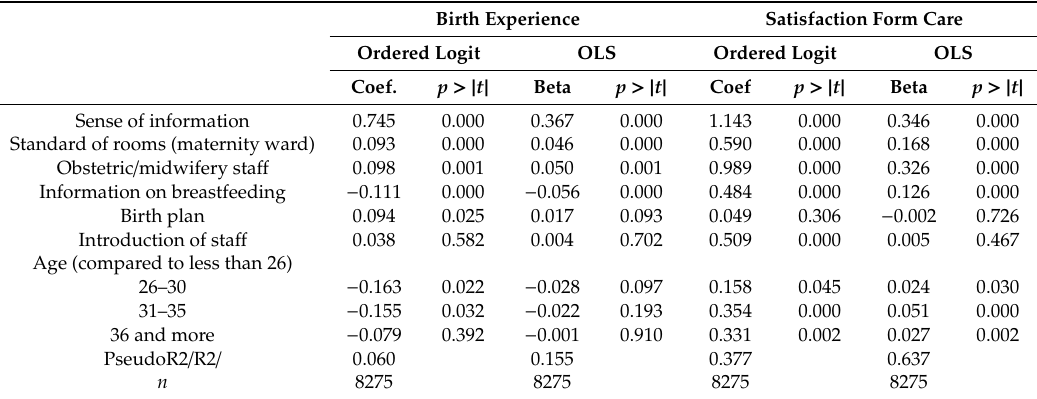
Table 3. Regression analysis for all respondents ( n =